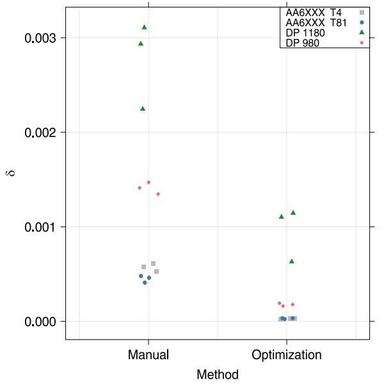
Residual (normalized), δ, for each stress-strain curve for each Method grouped by material. The x-axis values are shifted to minimize overplotting.